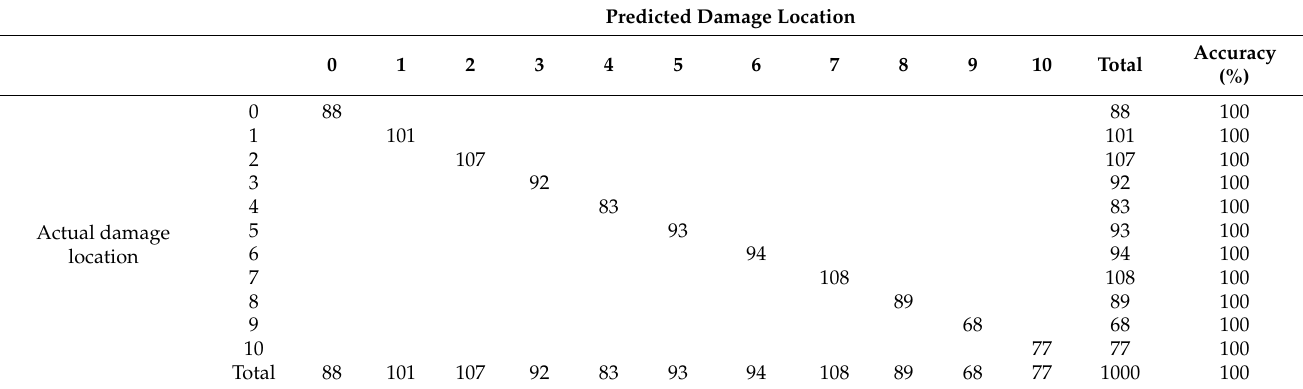
Table 8. Classification result of application datasets under random excitation.